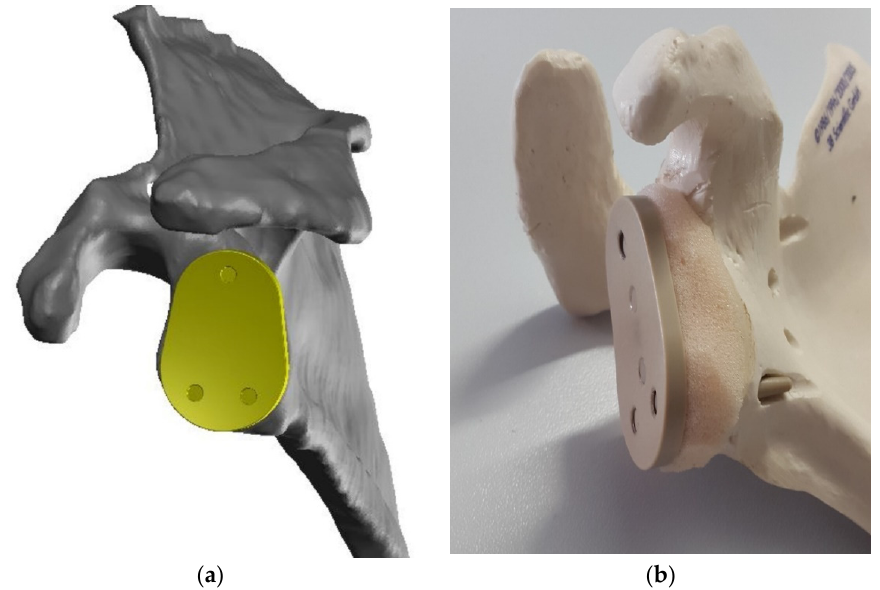
Figure 5. Visualization of dynamic variant of GlenoProtect on glenoid/scapula ( a ) digital model for simulation purpose (bone defect, augmentation not shown) and ( b ) analog model for development purpose (foam material simulates the bone augmentation).